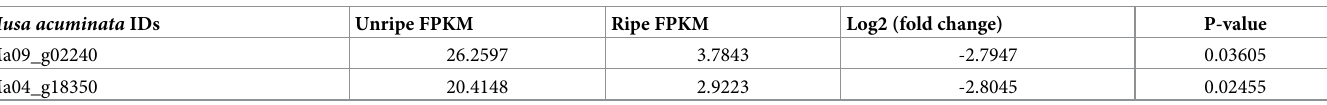
PLOS ONE | https://doi.org/10.1371/journal.pone.0254709 July 27,